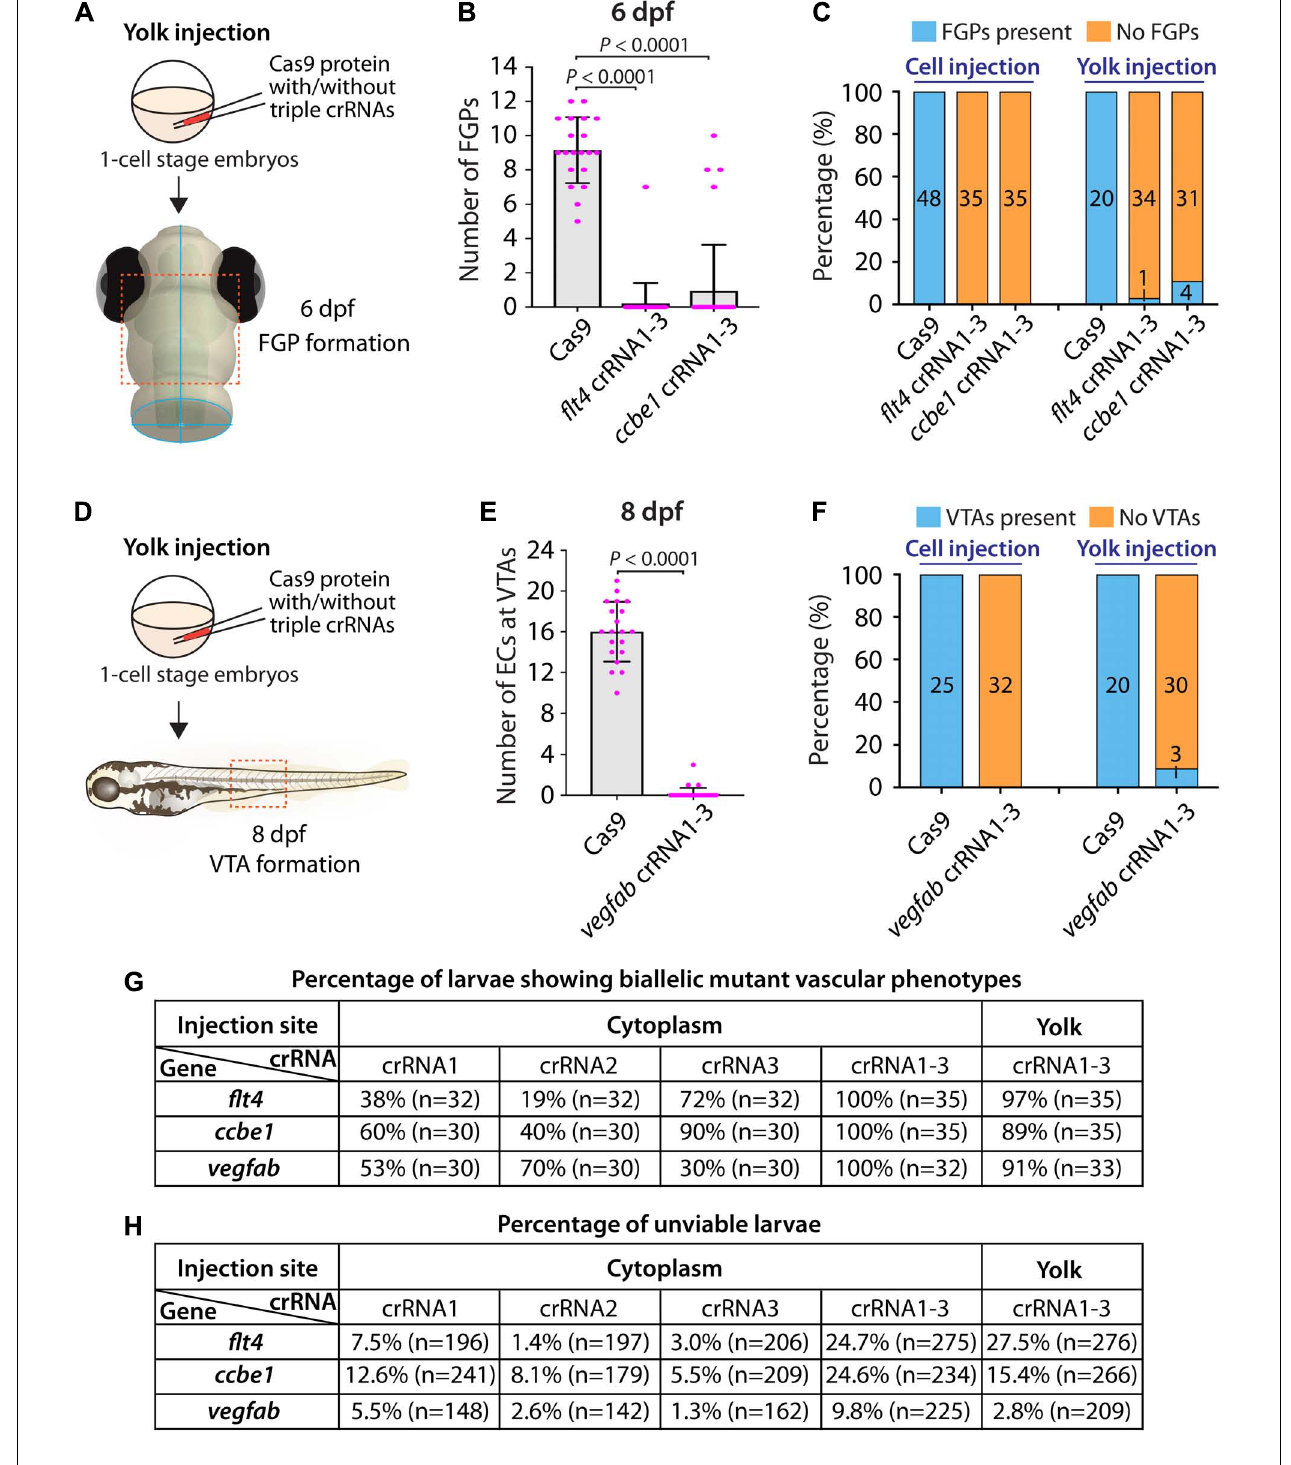
FIGURE 5 | Yolk injections of three dgRNPs per gene allowed efficient generation of biallelic F0 knockouts but were less consistent than cytoplasmic injections. (A) Experimental workflow of the yolk microinjection experiments for panel (B) . Injection cocktails containing Cas9 protein with and without the three flt4 or ccbe1 crRNA:tracrRNA duplexes were injected into the yolk of one-cell stage Tg(fli1:nEGFP);Tg(lyve1:DsRed) embryos. Injected progeny were analyzed at 6 dpf for FGP formation over the optic tectum. (B) Quantification of FGPs over the optic tectum at 6 dpf after yolk injection of Cas9 protein with and without the three flt4 or ccbe1 crRNA:tracrRNA duplexes ( n = 20 for Cas9 controls, n = 35 for flt4 crRNA1-3 and ccbe1 crRNA1-3). All flt4 dgRNPs-injected larvae except one failed to form FGPs